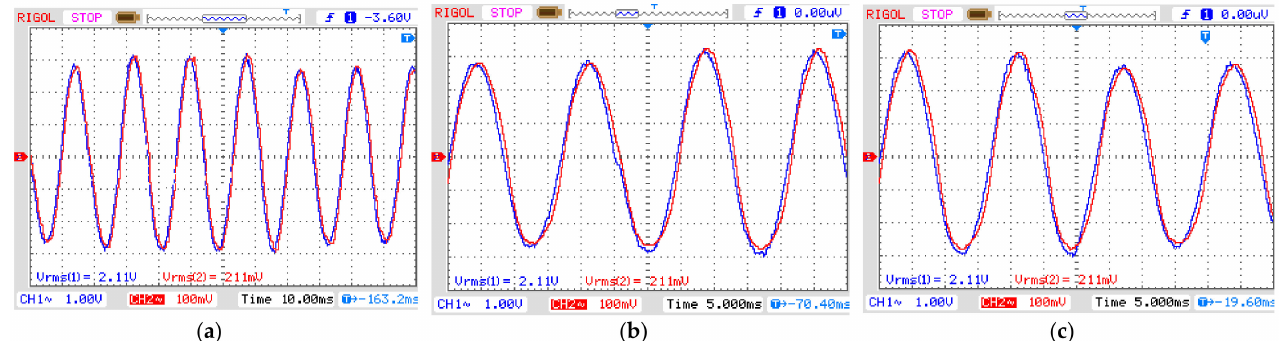
Figure 11. OVT input (CH1) and output (CH2) voltage for SWELL disturbance. Vertical axis: 1 V/div (CH1) and 100 mV/div (CH2). ( a ) Complete disturbance (horizontal axis: 10 ms/div); ( b ) Beginning of disturbance (horizontal axis: 5 ms/div); ( c ) End of disturbance (horizontal axis: 5 ms/div).